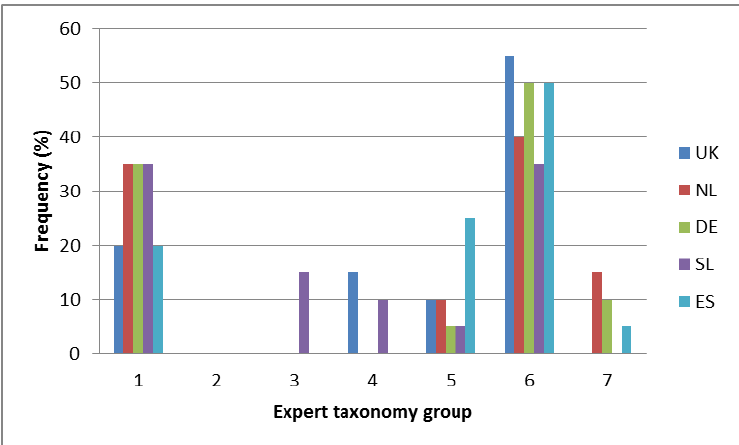
Figure A1. Frequency of structured sort placement of nutrition claims per country—‘Rich in vitamin C’ (Card 19).